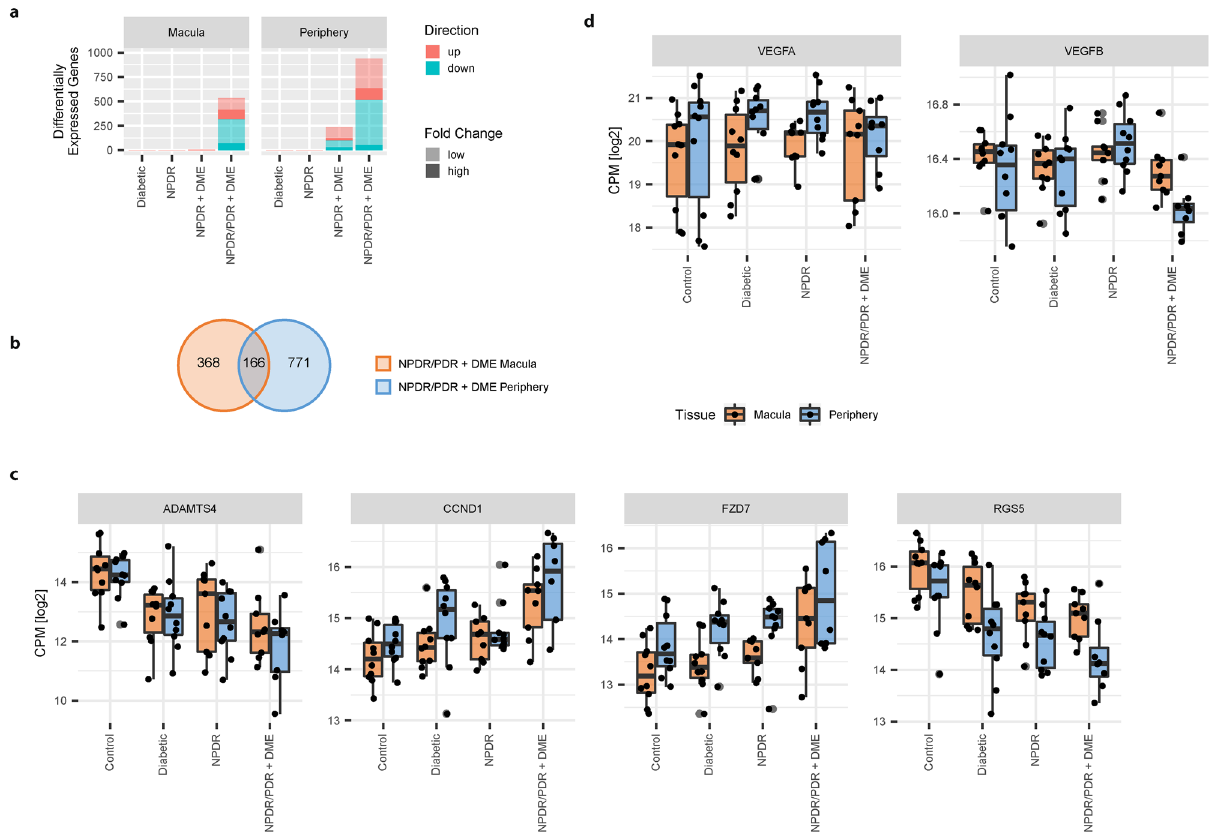
Figure 2. Significant changes in late stage disease progression: ( a ) Barplot with number of significant changes in RNA expression between disease groups and healthy control (BH adjusted p value < 0.05). Gene expression changes with fold-change below 50% are transparent. Up- and down-regulation are shown in red and blue respectively. ( b ) Venn diagram showing the overlap between macula and periphery of differentially expressed transcripts identified in the NPDR/PDR + DME group. ( c ) Log2 CPM expression values (black dots) of significantly changing genes identified from NPDR/PDR + DME samples with strongest mean fold- change between macula and periphery. Black line denotes median log2 CPM. Boxplot lower and upper hinges correspond to the first and third quartiles respectively. Whiskers extend to the largest expression value no further than 1.5 interquartile range from the hinge. Outliers are shown in transparent gray. ( d ) Log2 CPM values (black dots) of VEGFA and VEGFB expression throughout subsequent disease groups. Boxplot specifications correspond to those given in the previous